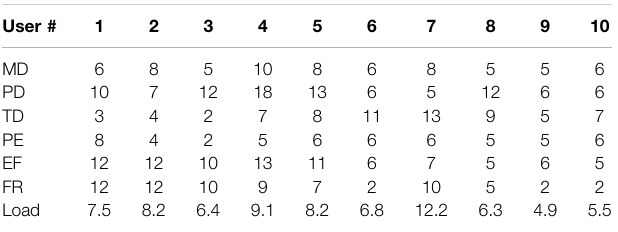
TABLE 2 | NASA TLX questionnaire results, tally of importance selections: w MD (cid:1) 3,